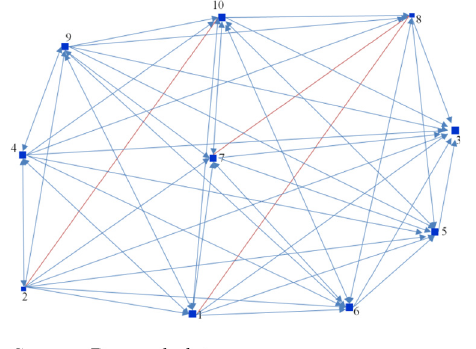
Figure 2. Graph of incubator